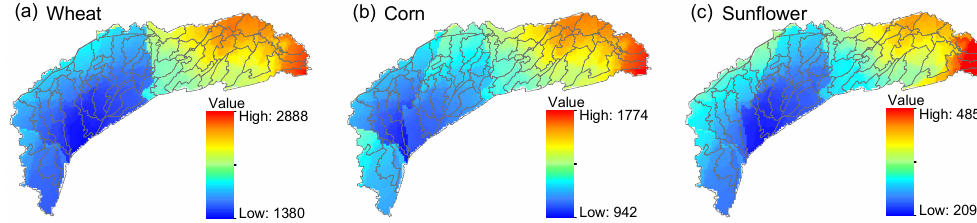
Figure 9. The spatial distribution of the total water footprint of crop production in the HID (m 3 t − 1 ).